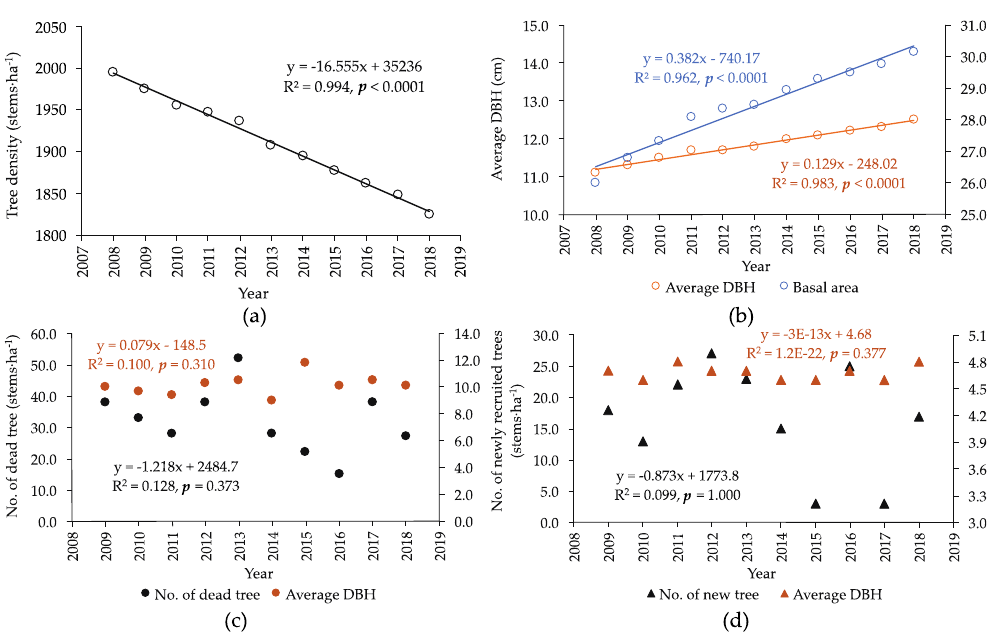
Figure 3. Changes in the forest structure from 2008 to 2018 of the permanent plot: ( a ) density of the living trees; ( b ) average diameter at breast height (DBH) and total basal area of the living trees; ( c ) number and average DBH of the dead trees; and ( d ) number and average DBH of the newly recruited trees. The regression lines indicate a significant level at p < 0.05.